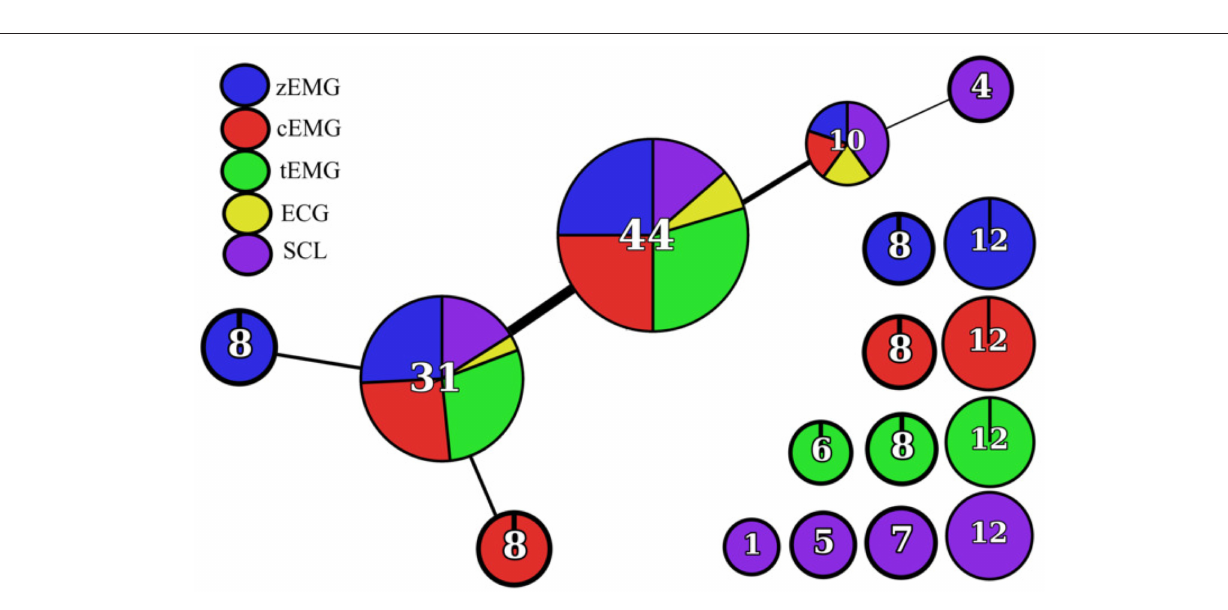
FIGURE 3 | Topological network rendered by the Mapper algorithm using k -NN distance as the filter